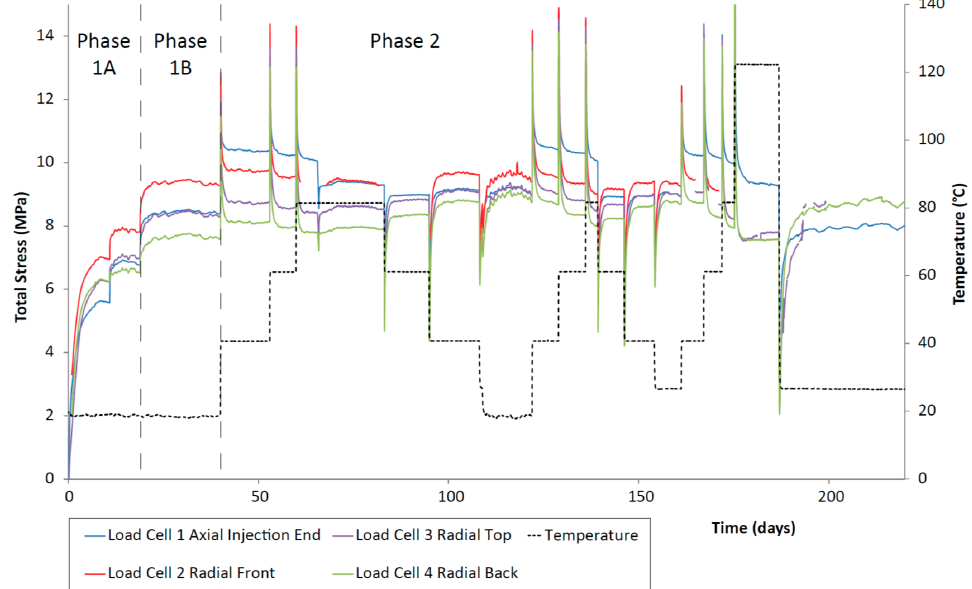
Figure 5. Total stress against time for the duration of the CVRF-1 experiment measured using the load cell stress sensors. Temperature (black dotted line) and testing phases are highlighted. Load cell 5 was inoperative during testing and has been removed from the analysis.